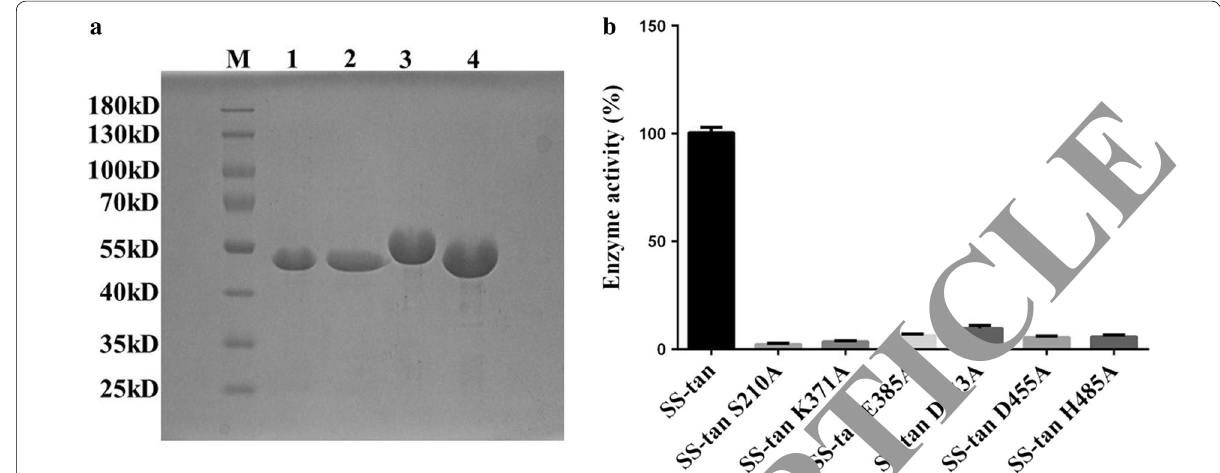
Fig. 2 a The purified tannases were analyzed with 12% SDS-PAGE. M: molecular mass of standards; (1) LP-tan; (2) LP-tan variant; (3) SS-tan; (4) SS-tan variant. b Activities of site-directed mutagenesis of SS-tan relative to wild-type of SS-tan. Tannic acid was used as the substrate and each measurement was performed in quintuplicate